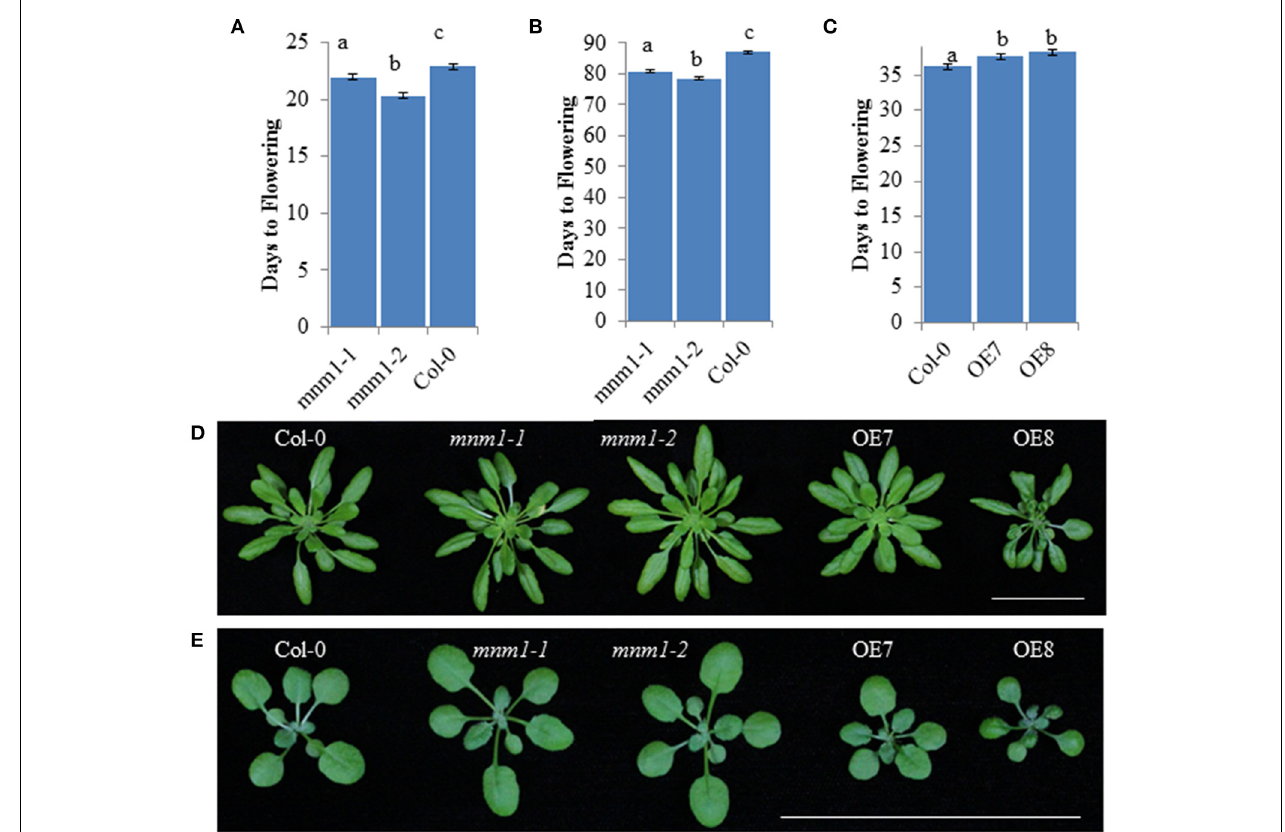
FIGURE 3 | Morphological analysis of MNM1 Genotypes. Letters show statistically different groupings within a graph as determined by ANOVA at a 0.001 level. All ANOVA models included genotype and the interaction of genotype and replicate. In all instances the interaction term was non-significant. All values are least squared means with standard error. For (A,B) , all genotypes were tested together in four independent experiments per day length with an average of 200 plants in total across the experiments for each genotype. For C, Col-0 and the two MNM1 OE genotypes were